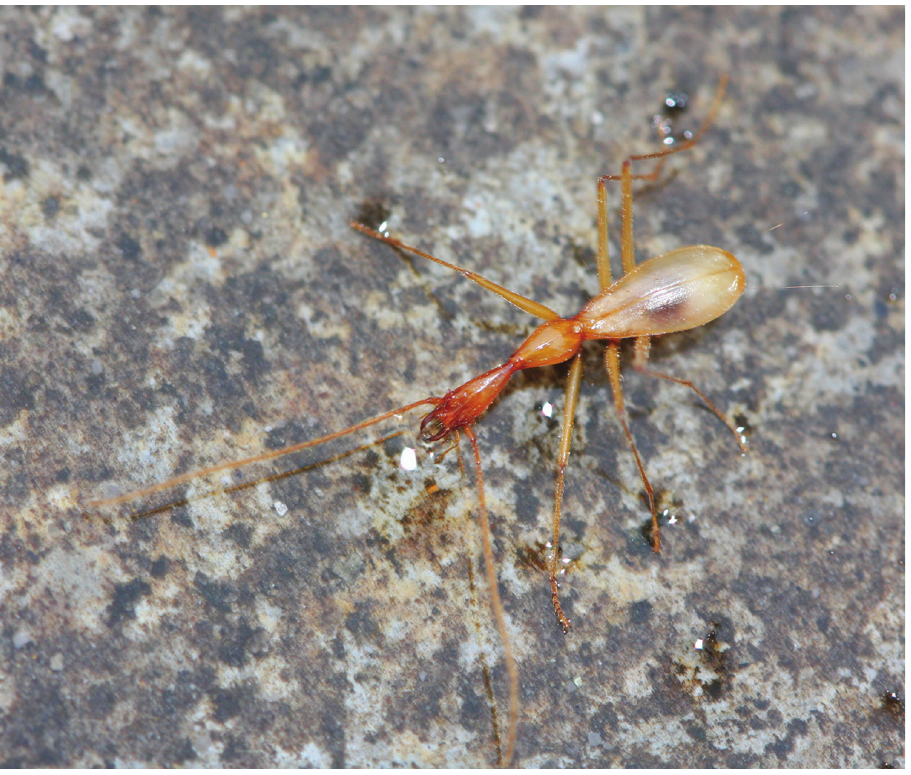
Figure 3. A living exemplar of Dongodytes (s. str.) grandis Uéno, 1998. supraorbital pores, genae more widened than in both D. fowleri and D. grandis ; labial suture traceable; mentum bisetose, concave basally; mentum tooth small and short, simple at tip; submentum 6-setose; palps very thin and slender; maxilla palpomeres III and IV glabrous; labial palp II bisetose on inner margin, 1.5 times longer than palp III which is glabrous; suborbital pores nearer neck than submentum. Antennae thin and very long, much longer than whole body including mandibles, extending over elytral apices from apical part of antennomere IX. Prothorax elongated, shorter than head, 1.67 times longer than wide, evidently tumid on propleura, widest at approximately 1/3 from base. Pronotum narrow and elongated, evidently wider than in both D. fowleri and D. grandis , twice as long as wide, PnL/PnW = 2.03; slightly wider than head, PnW/HW = 1.07; base wider than front (PbW/PfW = 1.6); widest at a little behind middle; lateral margins strongly sinuate before hind angles which are acute and sharp; anterior latero-marginal setae at approximately the apical 1/3, basal ones before hind angles, at exactly the sinuated points. Scutellum small. Elytra very elongated ovate, similar in both D. fowleri and D. grandis in shape and chaetotaxy, with well-marked lateral borders; EL/EW = 2.22, EL/PnL = 2.42, EW/ PnW=